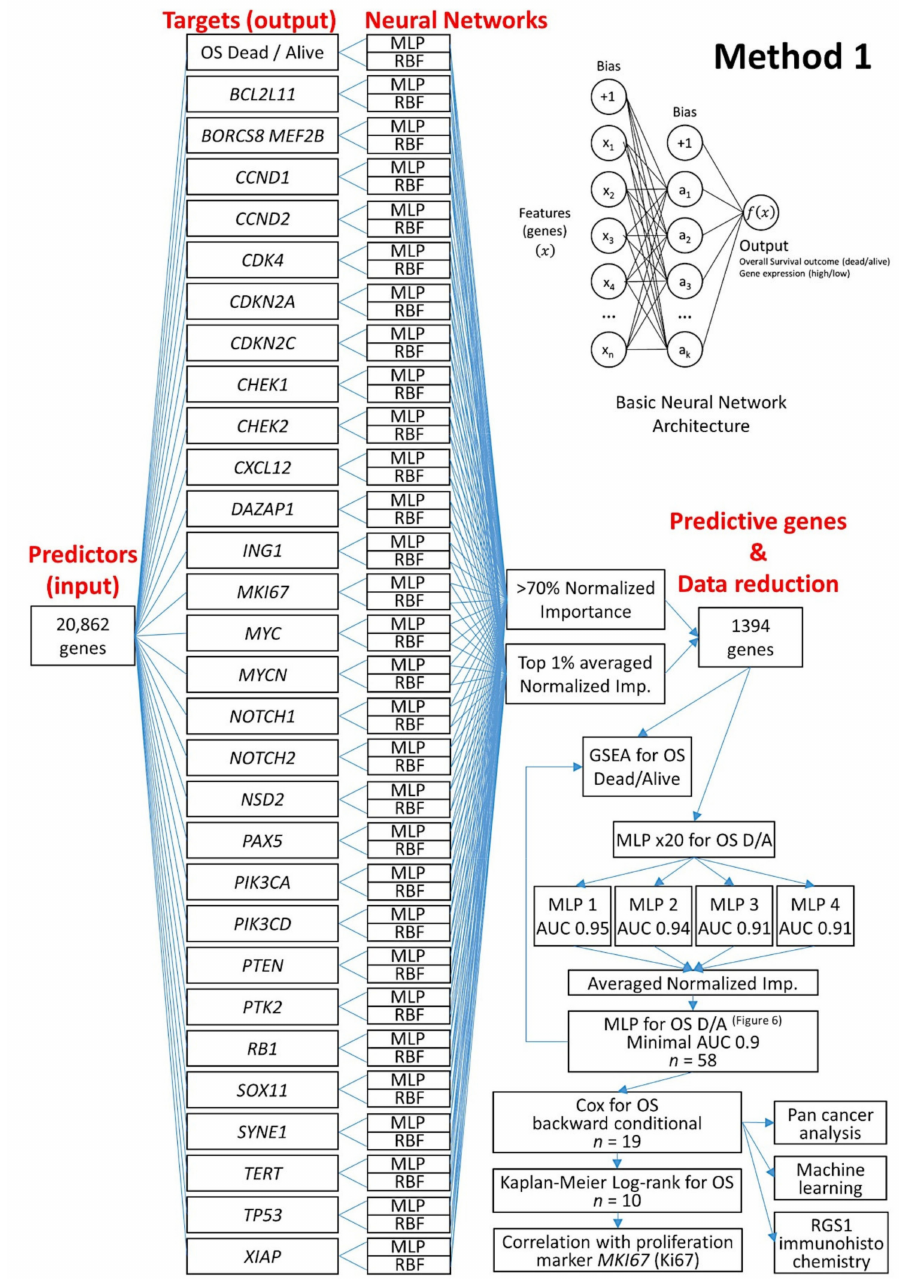
Figure 5. Artificial neural network analysis for the prediction of the overall survival of mantle cell lymphoma (Method 1). From a start point of 20,862 genes, using several neural networks, a correlation between the overall survival outcome and several mantle cell lymphoma pathogenic genes managed to reduce to a final set of 10 genes. These 10 genes correlated with the survival of the patients, but also with the proliferation index as expressed by MKI67 gene: MLP, multilayer perceptron; RBF, radial basis function; OS, overall survival; DA, dead/alive; GSEA, gene set enrichment analysis; AUC, area under the